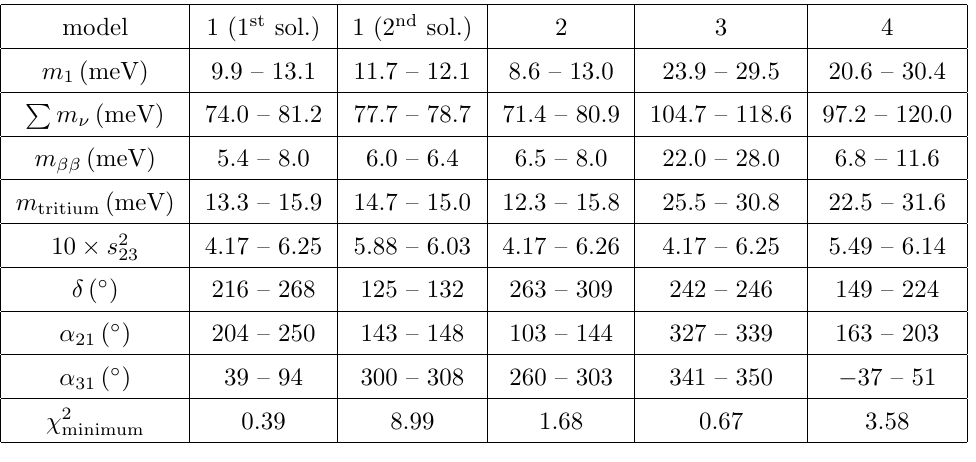
Table 1 . The 3 (cid:27) bounds for various observables in the models with normal neutrino mass ordering. These bounds correspond to (cid:31) 2 (cid:0) (cid:31) 2 (cid:20) 9, which is equivalent to 3 (cid:27) CL for one degree of minimum freedom; they take into account the cosmological bound P m (cid:23) < 0 : 12 eV [19, 20]. For model 5 the values are the same as for model 4, with the exceptions 10 (cid:2) s 2 (5.48 to 6.14), (cid:14) (154 (cid:14) to 213 (cid:14) 23